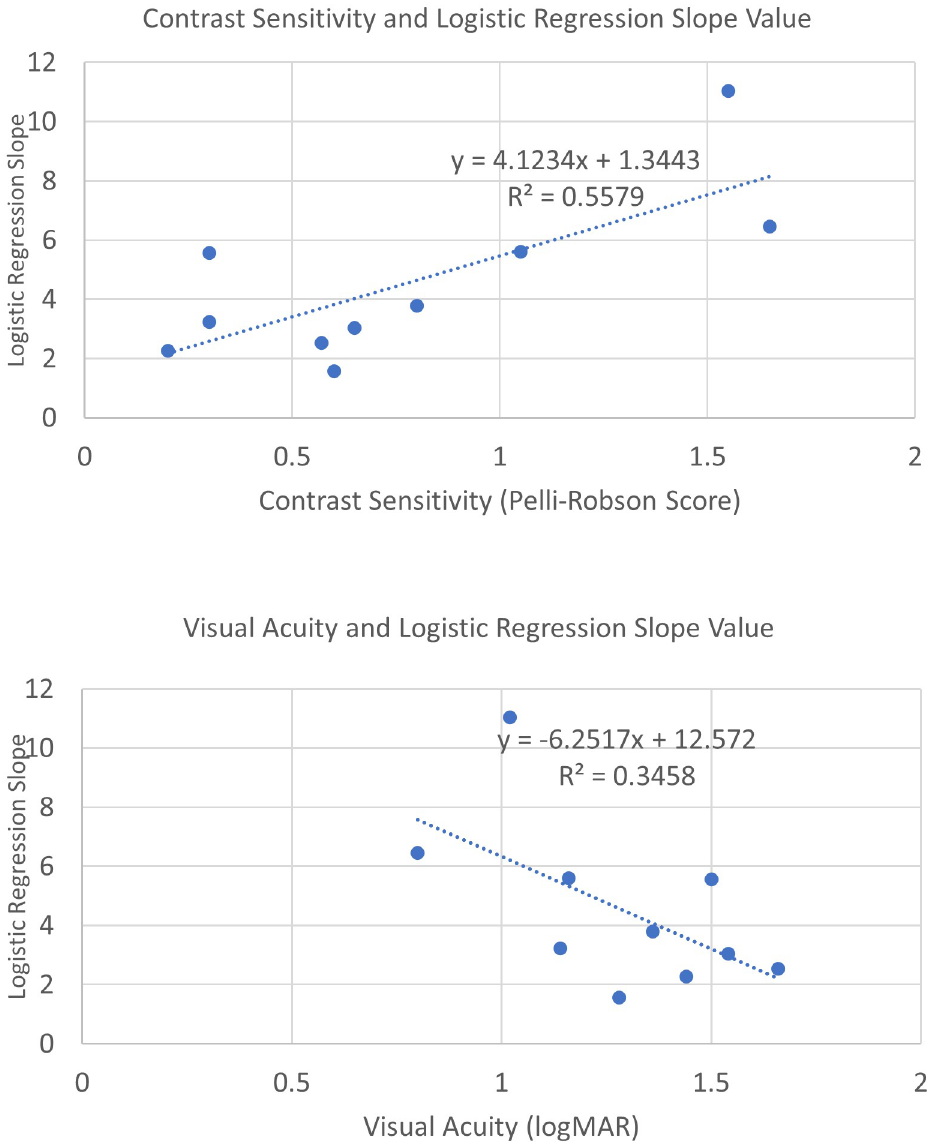
Fig 9. A scatterplot of logistic regression slope values of individual subjects and their visual acuities (upper panel) and contrast sensitivities (lower panel). Linear regression trend lines are also